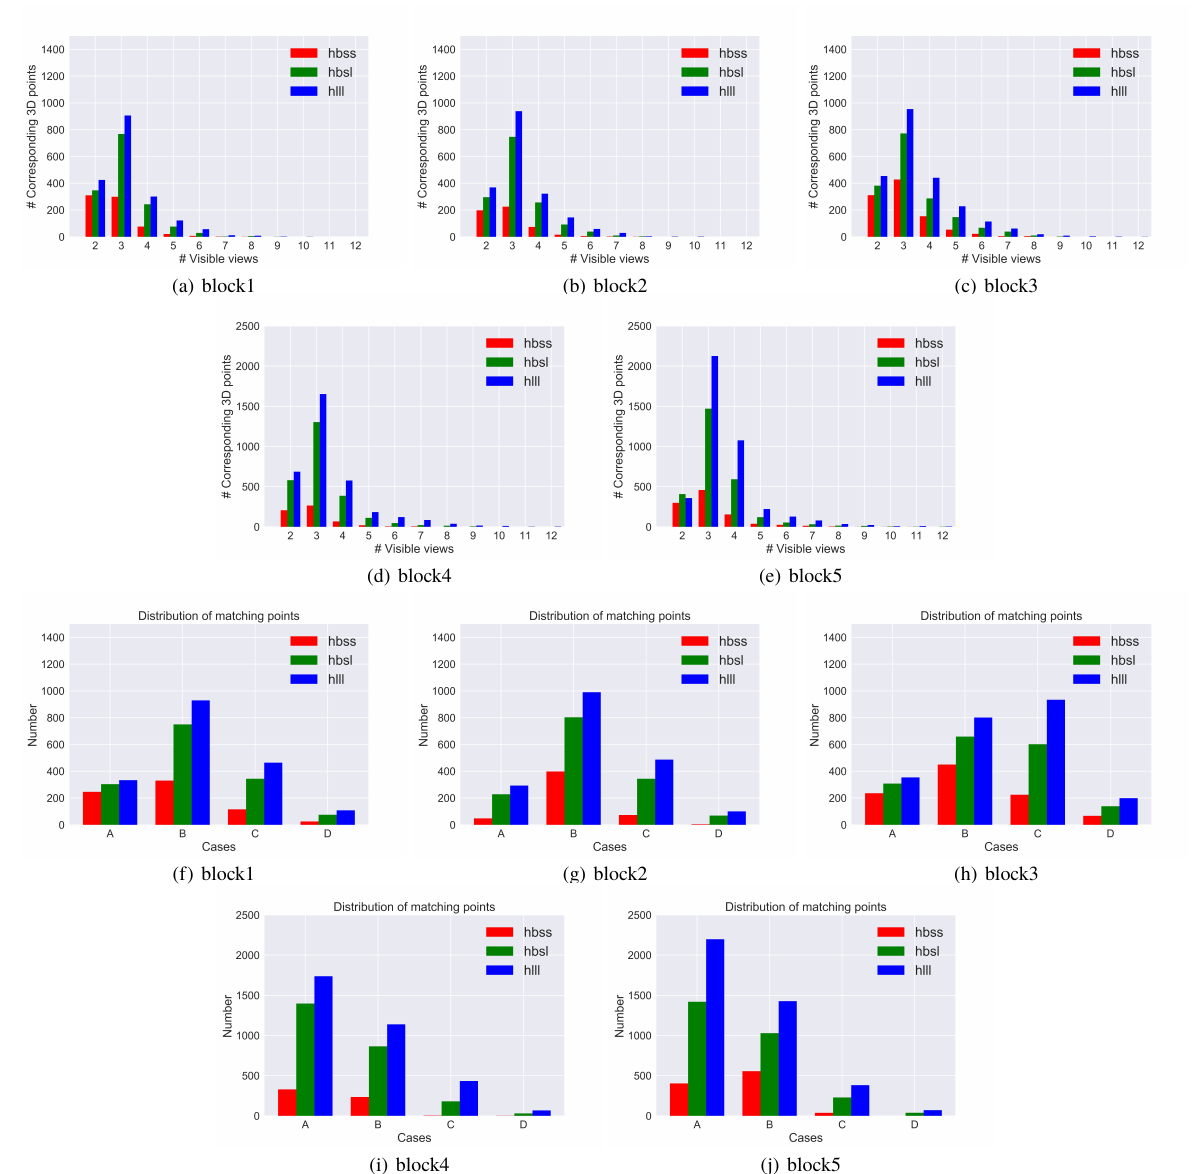
Figure 7. Resuls for the three pipeleins (see text for explanation of the abbreviations). Figure (a) to (e) indicate the distribution of the number of multiple rays per object point for blocks 1 to 5. Figure (f) to (j) indicates the distribution of involved cameras for the five blocks, where A=" only_nad_or_obl ", B=" nad_obl ", C=" obl_nad_obl " and D=" obl_obl